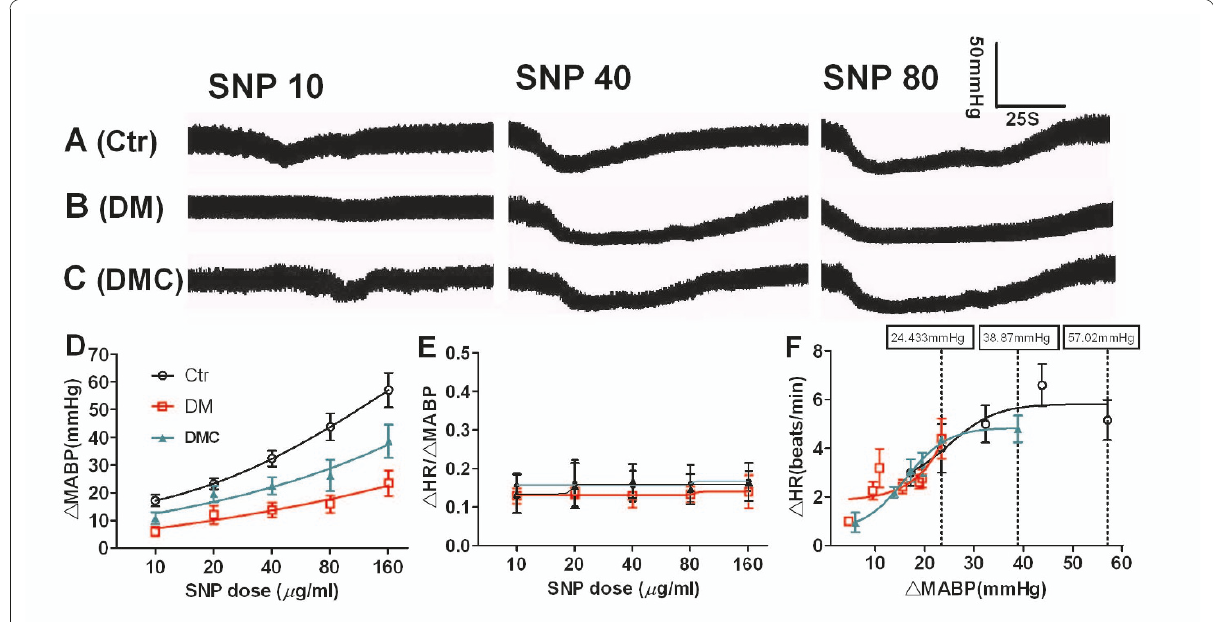
Figure 4 Effect of DMC on the attenuation of baroreflex sensitivity in DM rats following SNP administration . A: Normal rat(Ctr). B: DM rat (DM). C: DMC-treated DM rat (DMC). Trace: blood pressure changes induced by SNP application at 10, 40, and 80 μ g/ml. D) Dose dependent Δ